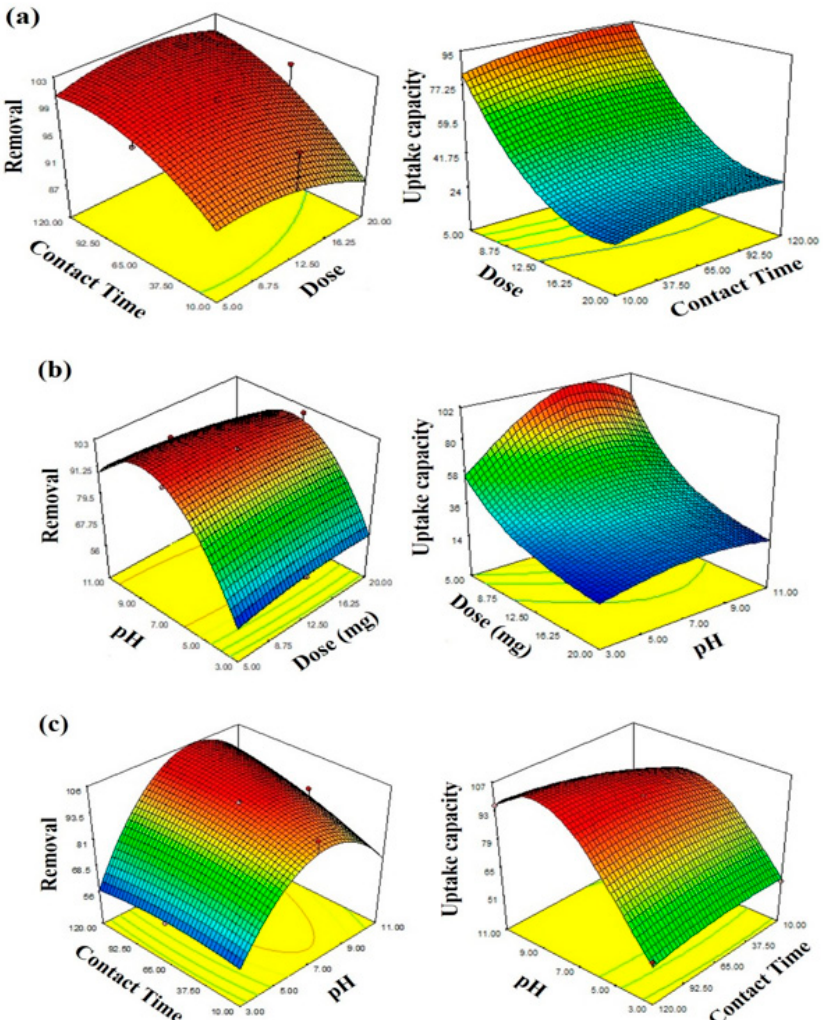
Figure 9. Surface response plots effects of adsorption parameters on removal and uptake capacity ( a ) interaction bio-PAC dose with contact time; ( b ) interaction between bio-PAC and pH; ( c ) interaction pH with contact time.